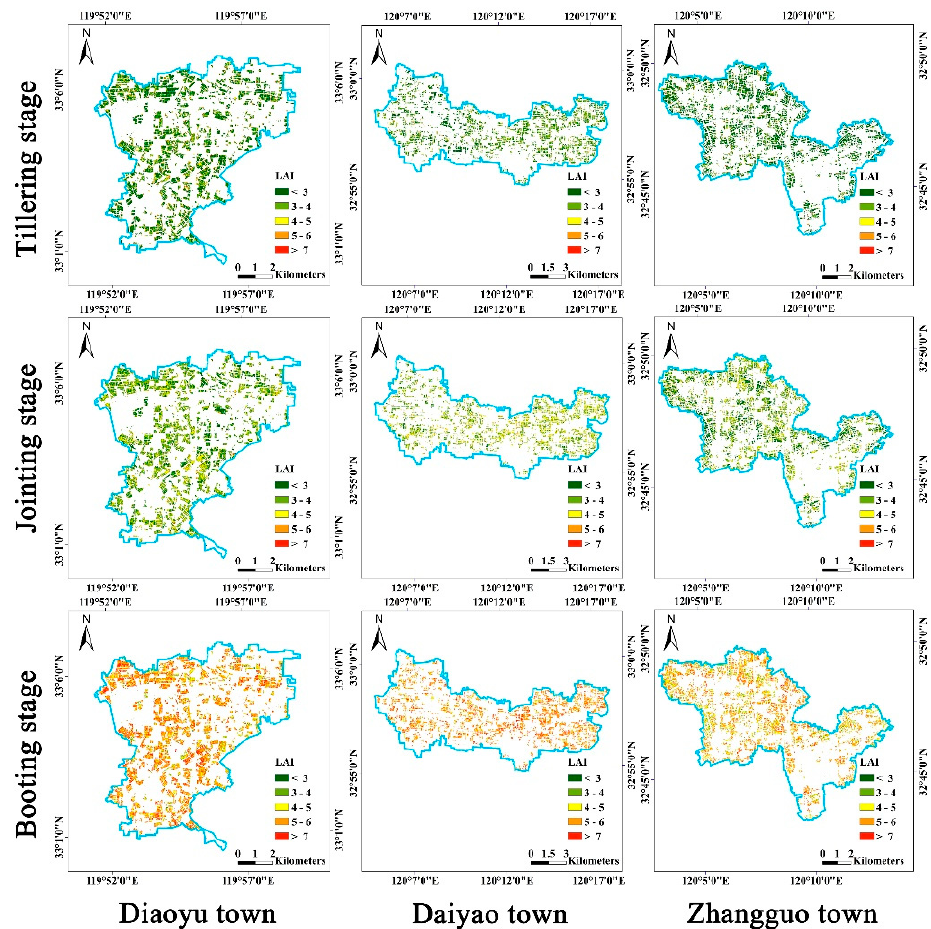
Figure 9. The distribution of LAI at three stages within the three towns studied here based on the fused image generated in this analysis.